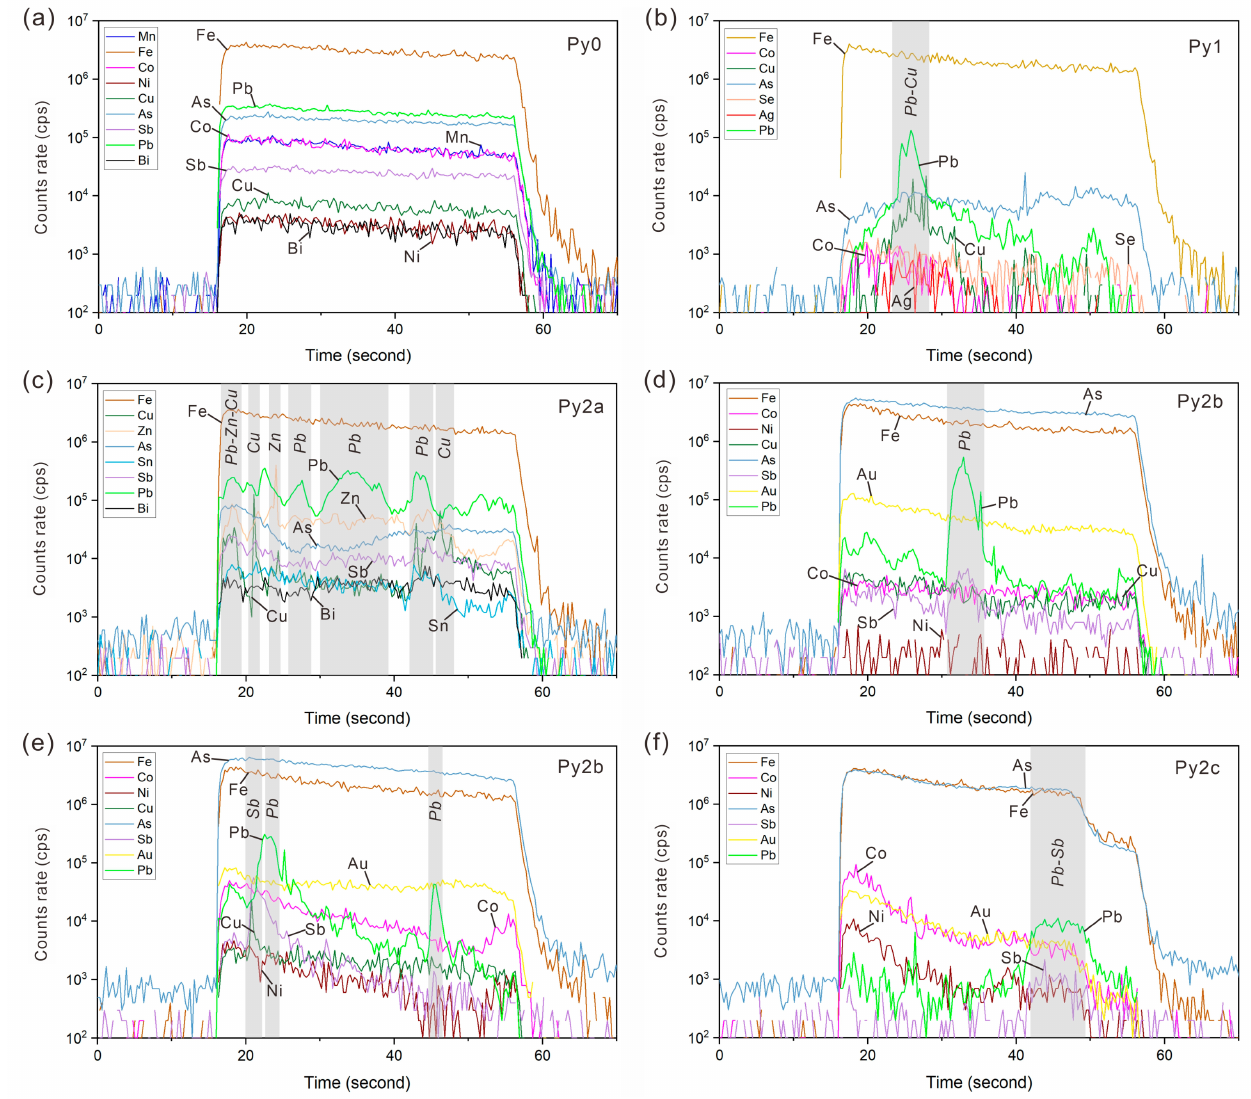
Figure 7. Representative LA-ICP-MS time-resolved depth profiles of different pyrites from the Dunbasitao gold deposit. Element signal peaks are marked by gray areas. ( a ) Time-resolved depth profile of Py0 shows that most element curves are smooth, which indicates these elements were incorporated into Py0 as solid solutions. ( b ) Time-resolved depth profile of Py1. Most trace element signals are weak, which reflects their low contents in Py1. Pb-Cu peak indicates the presence of Pb-Cu-bearing inclusion. ( c ) Time-resolved depth profile of Py2a showing strong signals of various elements and many element peaks. ( d ) Time-resolved depth profile of Py2b showing the strong Au signal. The curve of Au is smooth, which suggests the Au occurs in the form of lattice gold. Pb peak indicates the presence of Pb-bearing inclusion, probably galena. ( e ) Time-resolved depth profile of Py2b showing the Sb and Pb peaks, which are probably due to the presence of stibnite and galena inclusions. ( f ) Time-resolved depth profile of Py2c whose Au signal is significantly weaker than that of